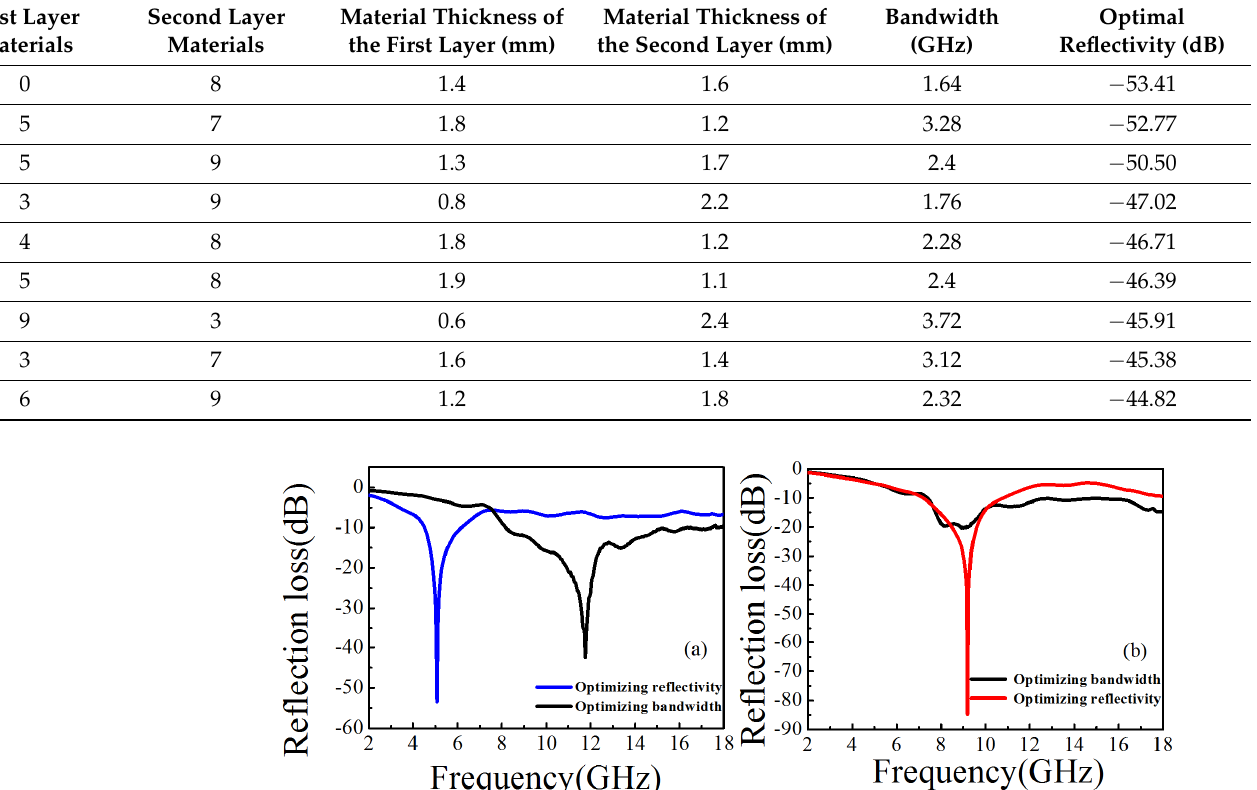
Figure 8. The optimized curves for the two-layer materials ( a ); the optimized curves for the three- layer materials ( b